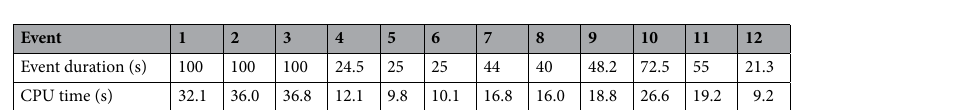
Figure 15. Fragility surfaces for: ( a ) the Optimal solution #1; ( b ) the Optimal solution #2; ( c ) the Optimal solution 3; and relevant fragility curves for: ( d ) n im = 900; ( e ) n im = 1600; ( f ) n im = 2900; these values of n im were taken from the values of O 2 in Fig. 9.